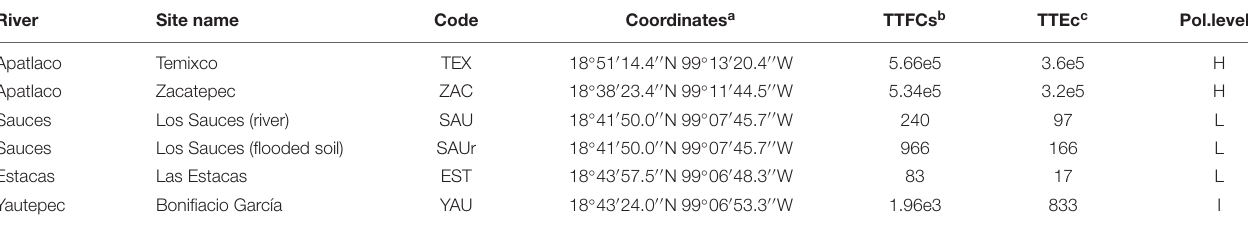
TABLE 1 | Sampling sites for this study in Morelos, Mexico and pollution level based on counts of thermotolerant fecal coliforms (TTFCs) and thermotolerant E. coli (TTEc) colony forming units (cfu/100 ml) measured in the water column.